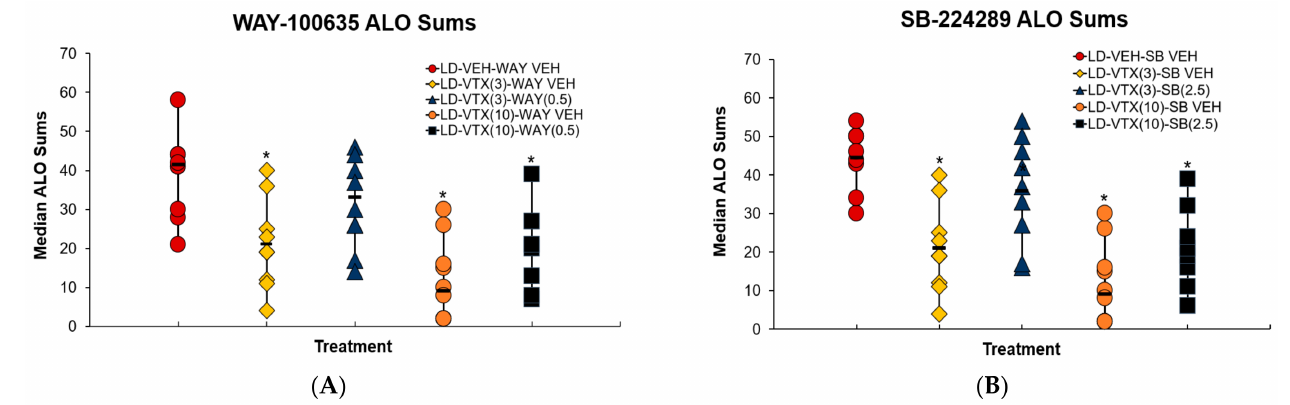
Figure 5. Experiment 2: Role of 5-HT 1A and 5-HT 1B Receptors in Vortioxetine’s Behavioral Effects.